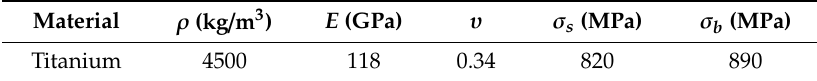
Table 5. Material parameters of titanium.